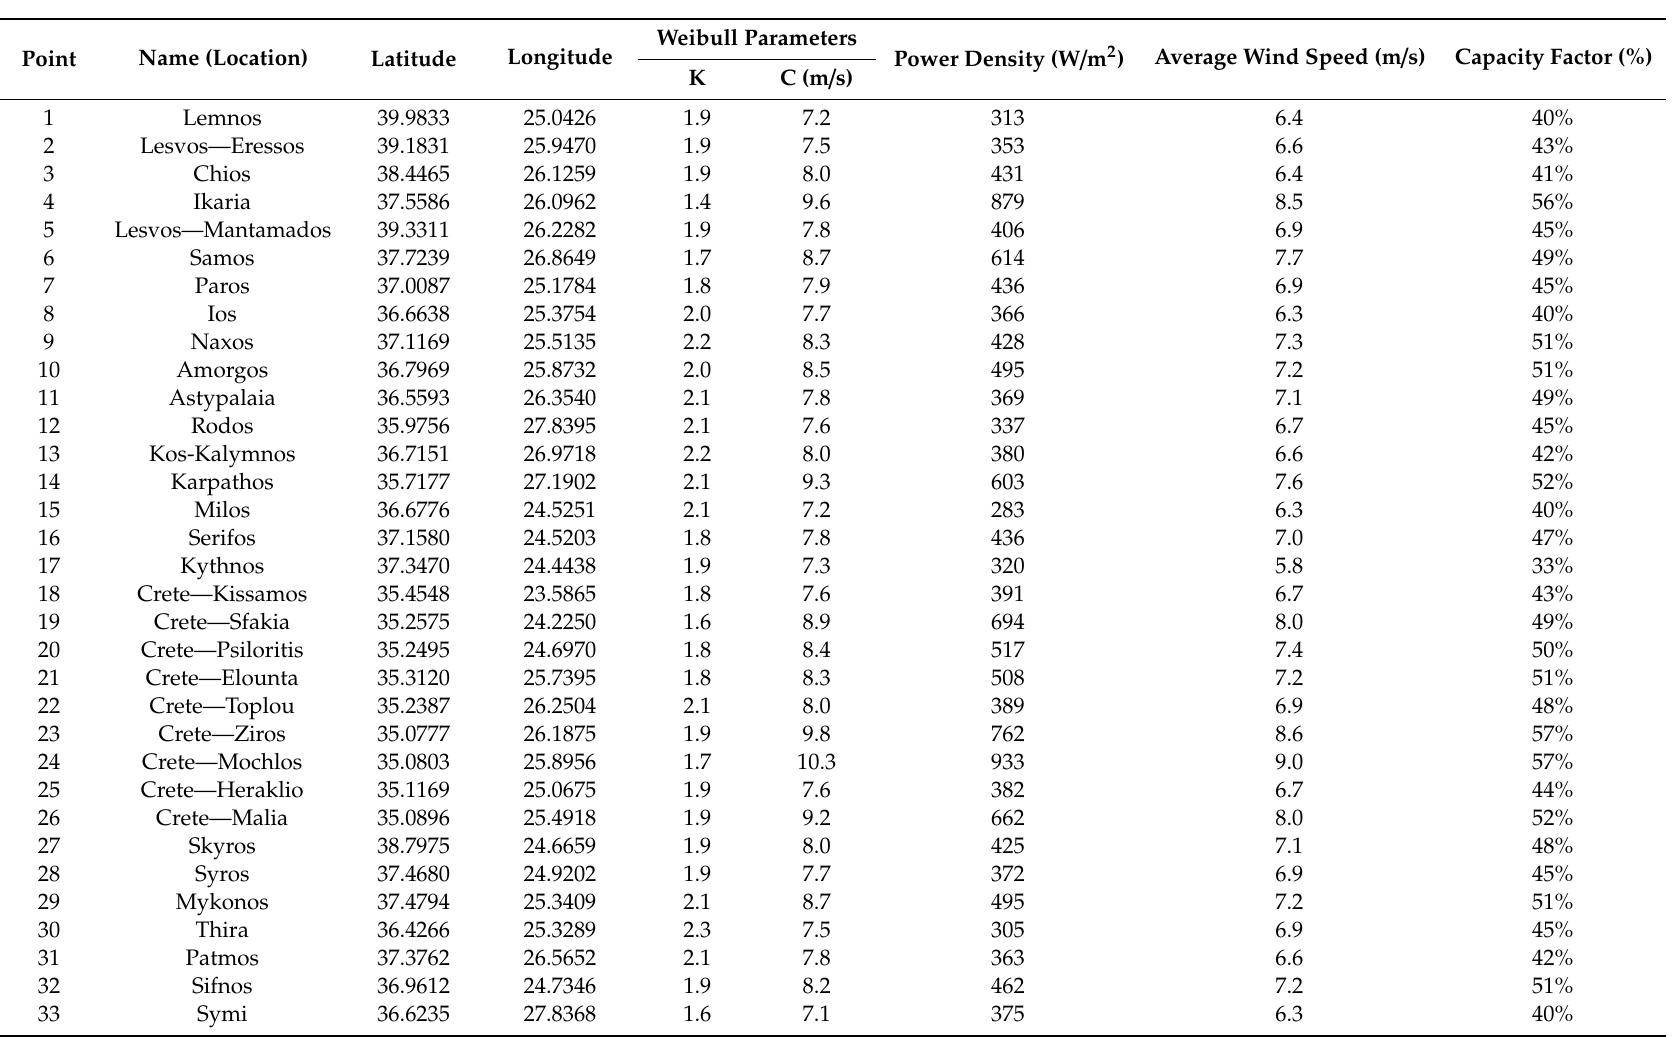
Table 6. Wind data based on mesoscale typical wind year data